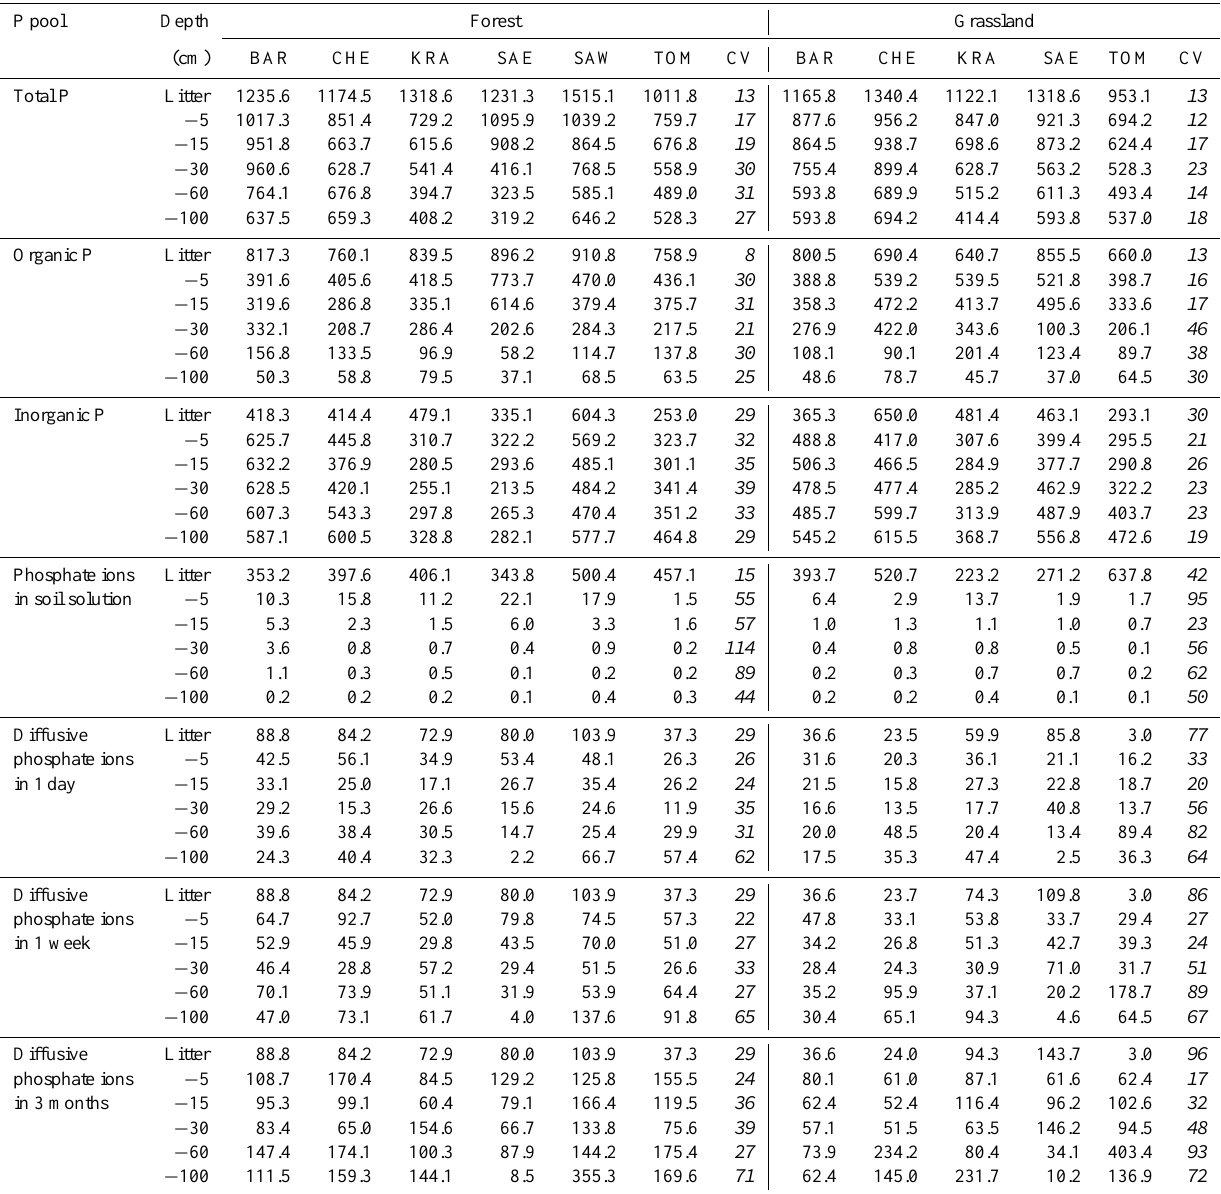
Table 2. Phosphorus concentrations of different pools measured in litter and soil layers of south-western Siberia. Concentrations are expressed in µgPg − 1 soil (or litter); depth is in cm. “Litter” means all the dead plant material deposited on the soil surface (senescing leaf litterfall, small branches and senescing understorey vegetation in forests; senescing herbaceous vegetation in grasslands), i.e. mainly OL and OF horizons and possibly OH (at BAR, CHE, KRA and SAE) at the date of